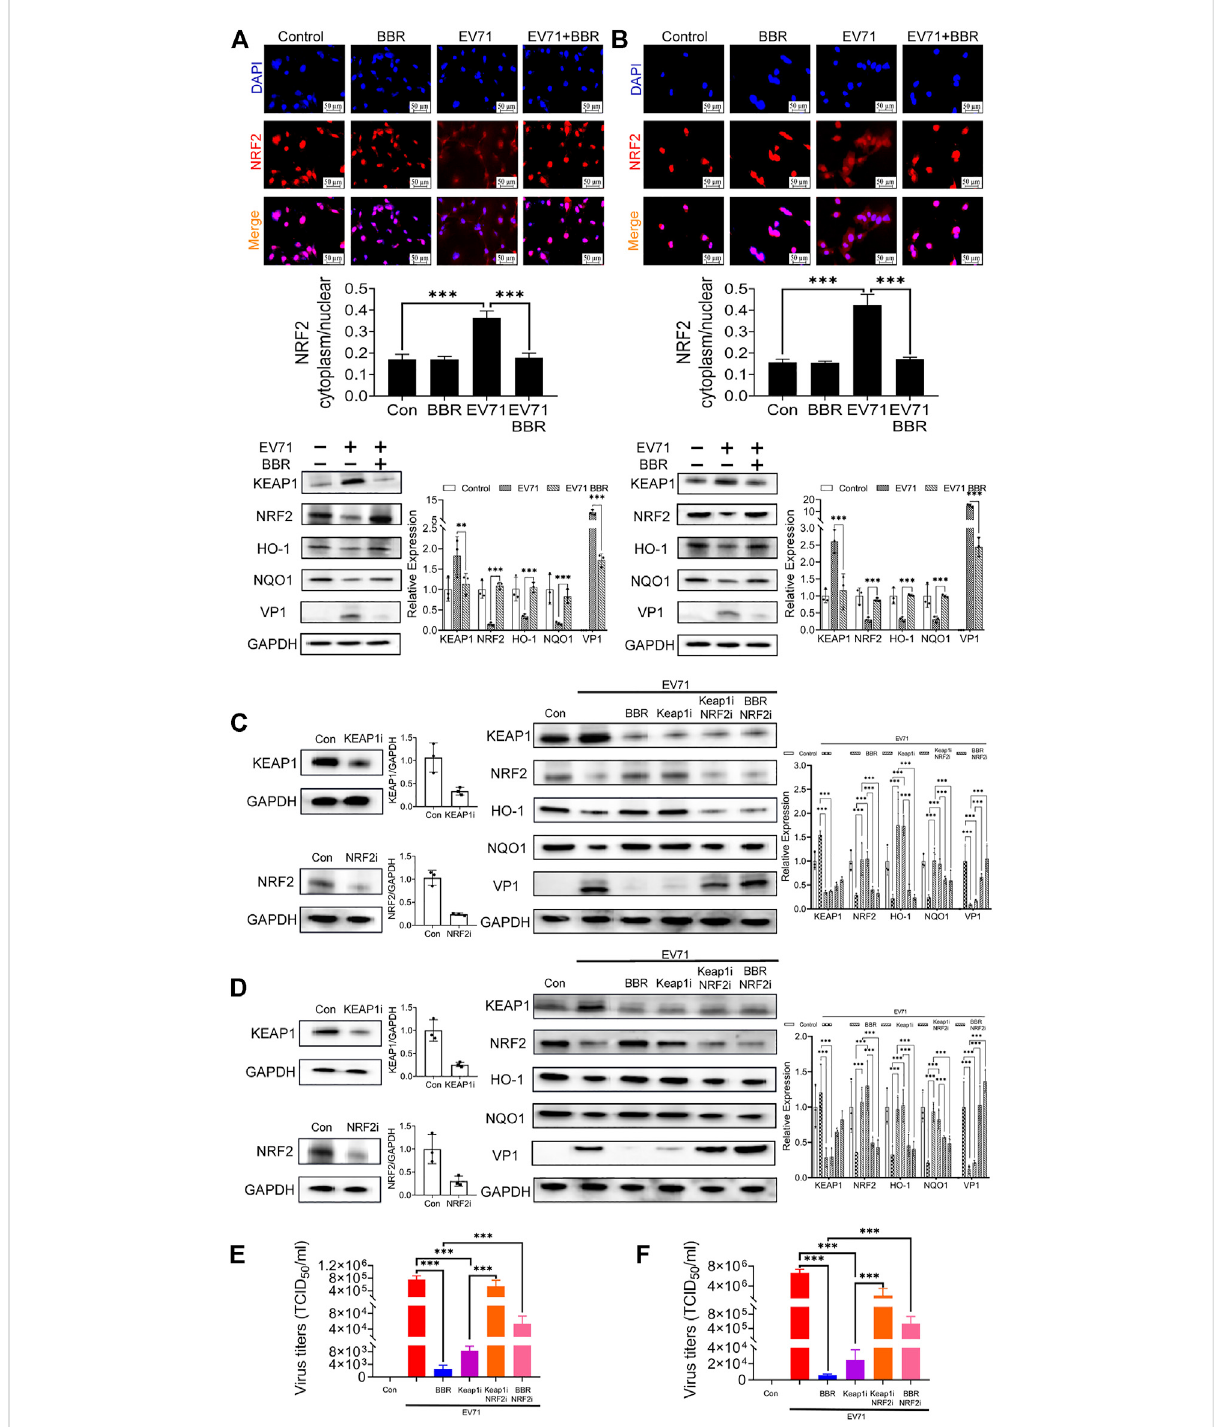
Effect of BBR in regulating Keap1-Nrf2 axis and downstream antioxidant proteins. Effects of BBR on the nuclear translocation of Nrf2 and expression of related proteins in (A) primary astrocytesand (B) U251 cells. Primaryastrocytes and U251wereinfectedwith EV71 (MOI= 1) for 2 h and then treated with BBR (5 μ M) for 24 h. The cells were subjected to immuno fl uorescence staining with DAPI (Blue) and Nrf2 (Red) ( n = 3). The red fl uorescenceintensityincytoplasm andnucleusofthese images wasanalyzedbyHigh ContentImage Processing andAnalysisSystem,andthe ratiowascalculated.bar=50 μ m.TheexpressionofKeap1,Nrf2,HO-1,NQO1,andEV71VP1proteinswereexaminedbyWesternblot.Thein fl uence of Keap1 and/or Nrf2 knockdown on the antiviral ef fi cacy of BBR in (C,E) primary astrocytes and (D, F) U251 cells. Western blot analysis was performed 24 h after siRNAs transfection in (C) primary astrocytes and (D) U251 cells. Virus titers were analyzed 72 h after transfection in (E) primary astrocytes and (F) U251 cells ( n = 10). Data are presented as SD. Statistical signi fi cance was compared between two groups was represented by asterisks marked correspondingly in the fi gures, ** p < 0.01, *** p <